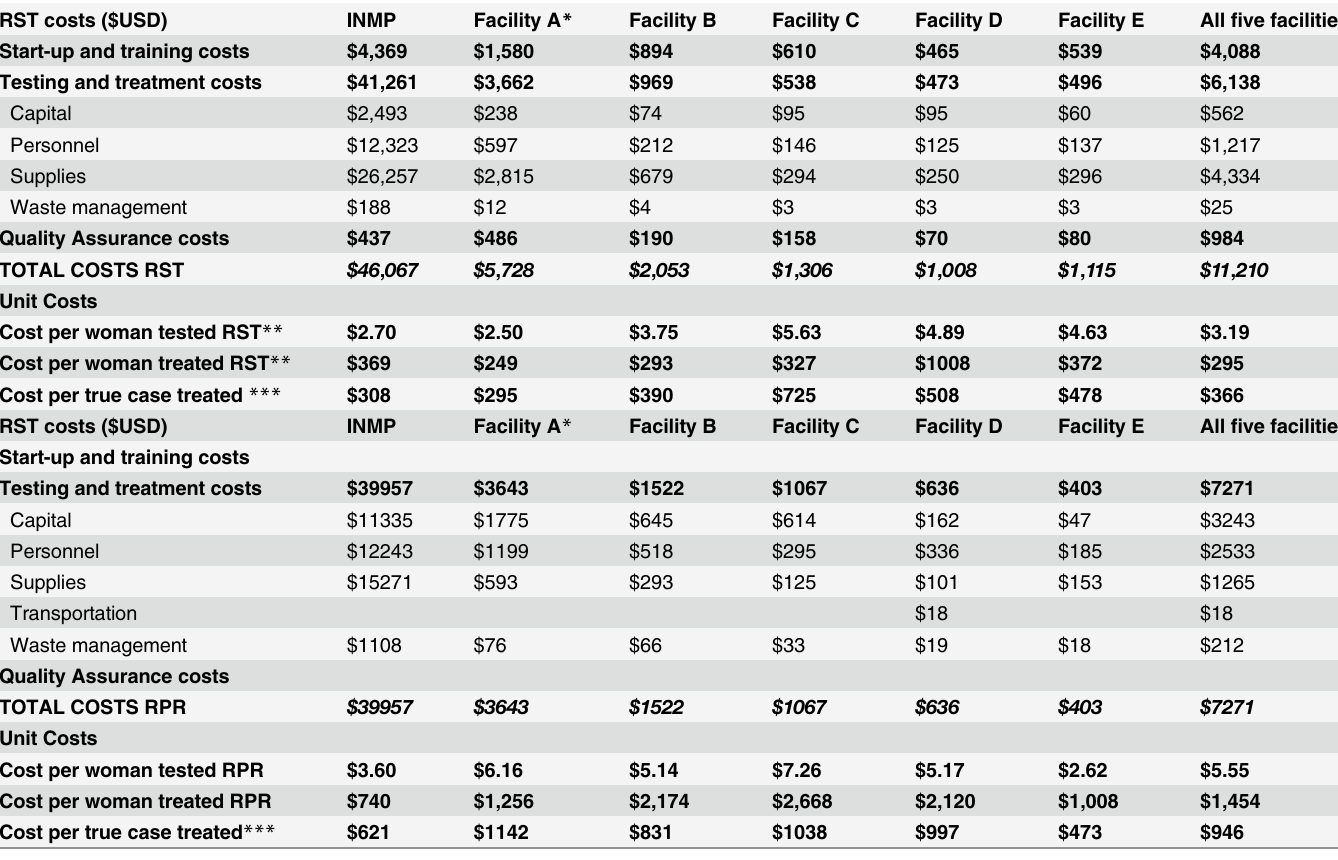
Table 2. Total screening and treatment costs of RST and RPR (USD).